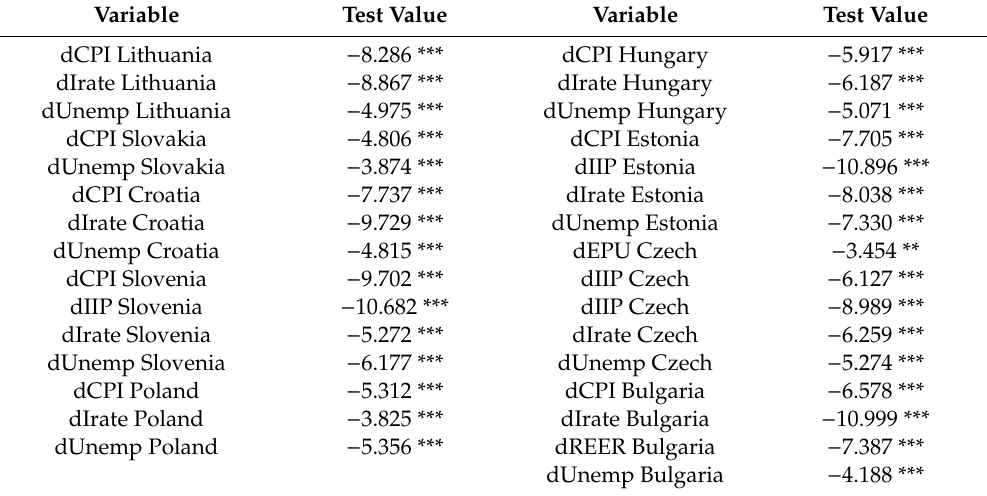
Table A2. Unit root test on di ff erenced values of non-stationary variables in Table 1.